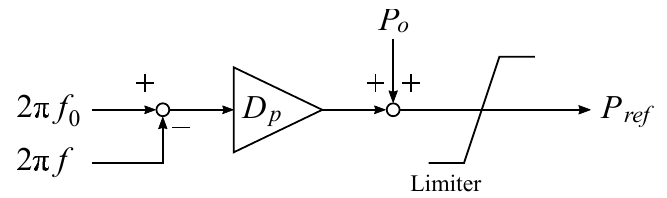
Figure 4. Block diagram of active power reference generation strategy.